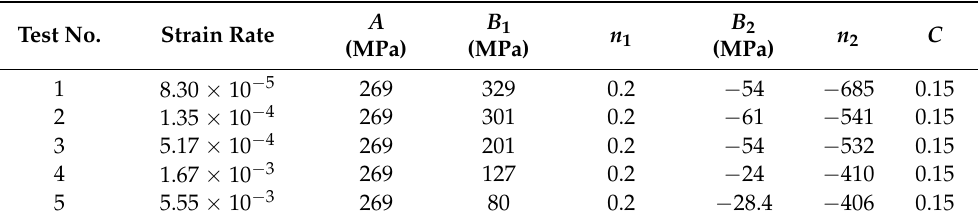
Table 4. Modified model parameters for biaxially tensile condition at TD. Test